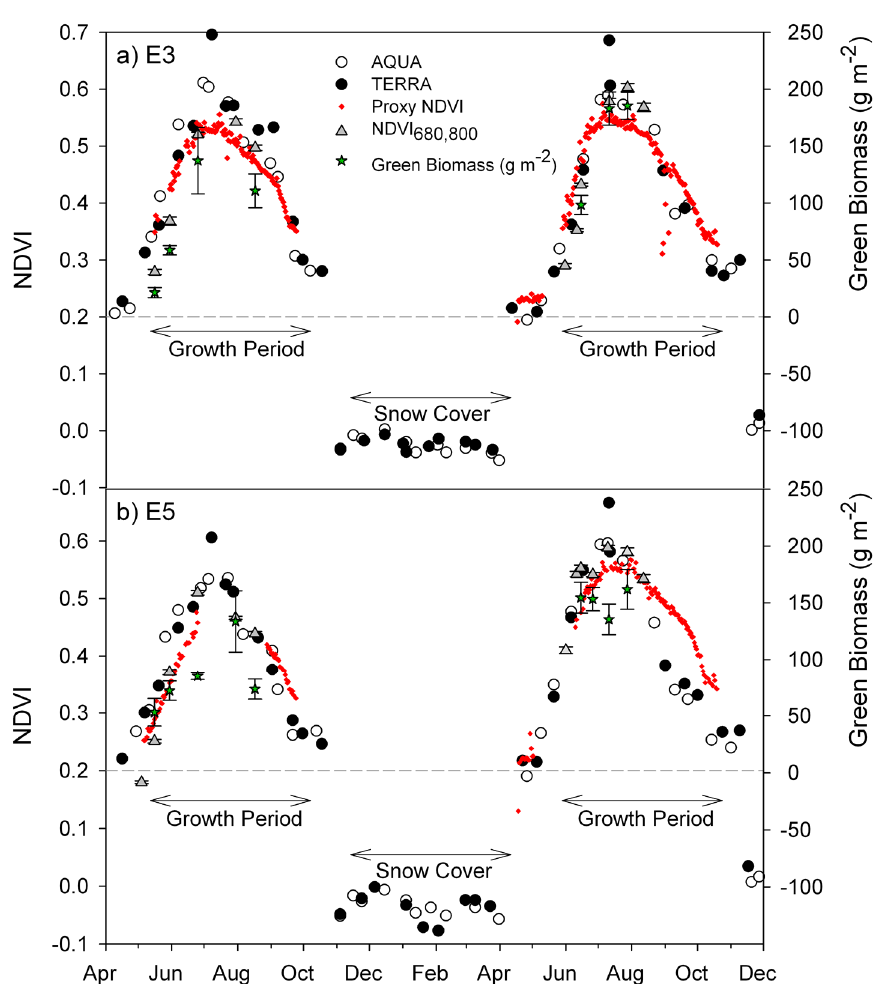
Figure 5. Time series (2012–2013) of NDVI 680,800 collected from spectrometer with grid method, proxy NDVI from 2-channel sensors on phenology station (5-h averaged), MODIS NDVI (Aqua and Terra sensors), green biomass, at ( a ) E3 site; and ( b ) E5 site. Low (<0) NDVI values due to winter snow